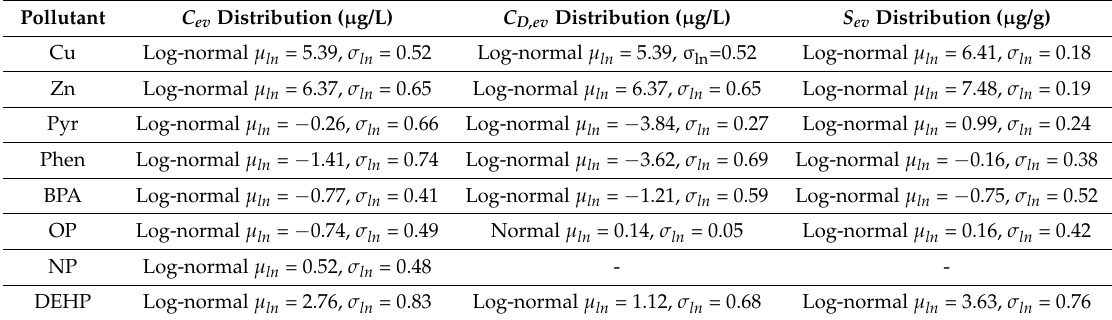
Table A3. Summary of event mean concentration ( C ev ), event mean dissolved concentration ( C D,ev ) and event mean particle concentration ( S ev ) distributions used to estimate inlet concentrations for unsampled events for each pollutant. C D,ev,in and S ev,in distributions are not given for NP as turbidity was not used for this pollutant.